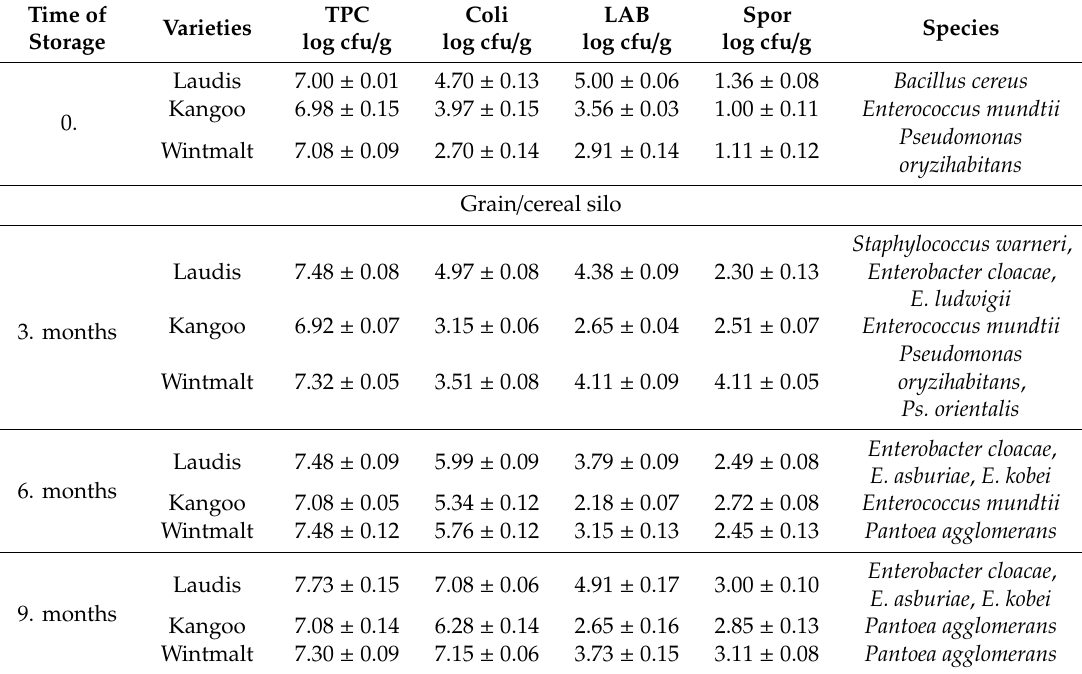
Table 6. Quantitative and qualitative composition of various groups of microorganisms in malt depending on the time and type of storage of the three varieties of